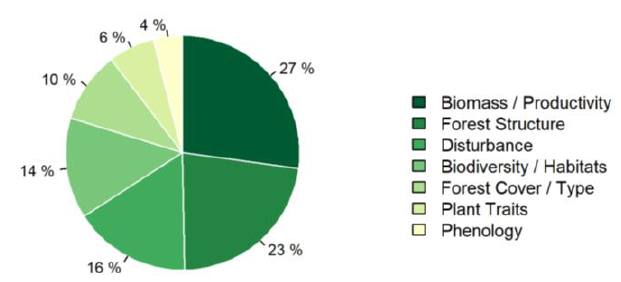
Figure 16. Examined research topic categories. Note that some studies cover different topics, which may result in multiple entries.